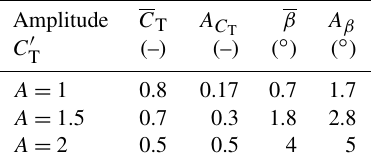
of the three different Table 2. Average C T and amplitude A C T thrust coefficient oscillations whose results are discussed in Sect. 6, as well as the mean pitch angle average β and amplitude A β used to achieve these signals. Note that, as explained in Sect. 2, these collective pitch settings are not identical for different frequencies. Instead, they are tuned such that the mean and amplitude of C T as given below are followed as accurately as